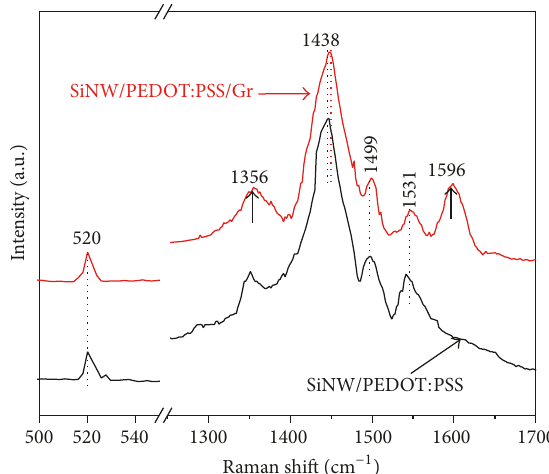
Figure 4: Raman spectra of SiNW/PEDOT:PSS and SiNW/ PEDOT:PSS containing functionalized